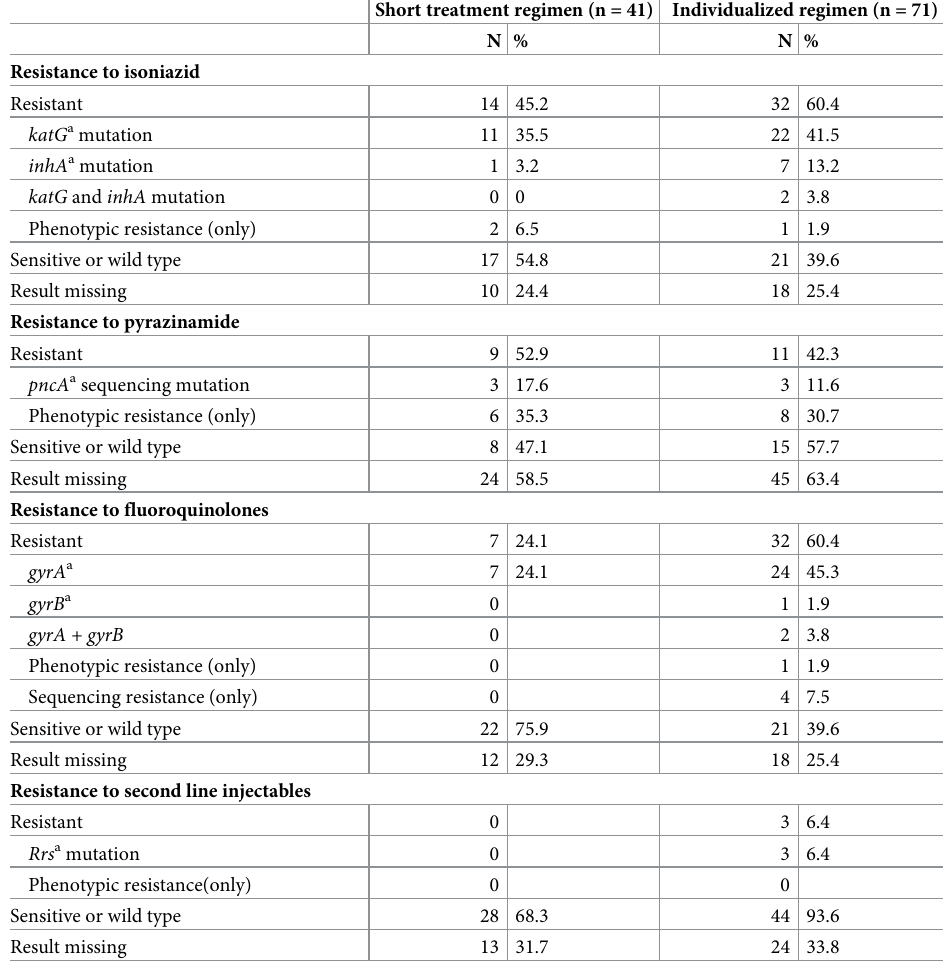
Table 3. Resistance pattern among patients who initiated treatment. Short treatment regimen (n = 41) Individualized regimen (n =